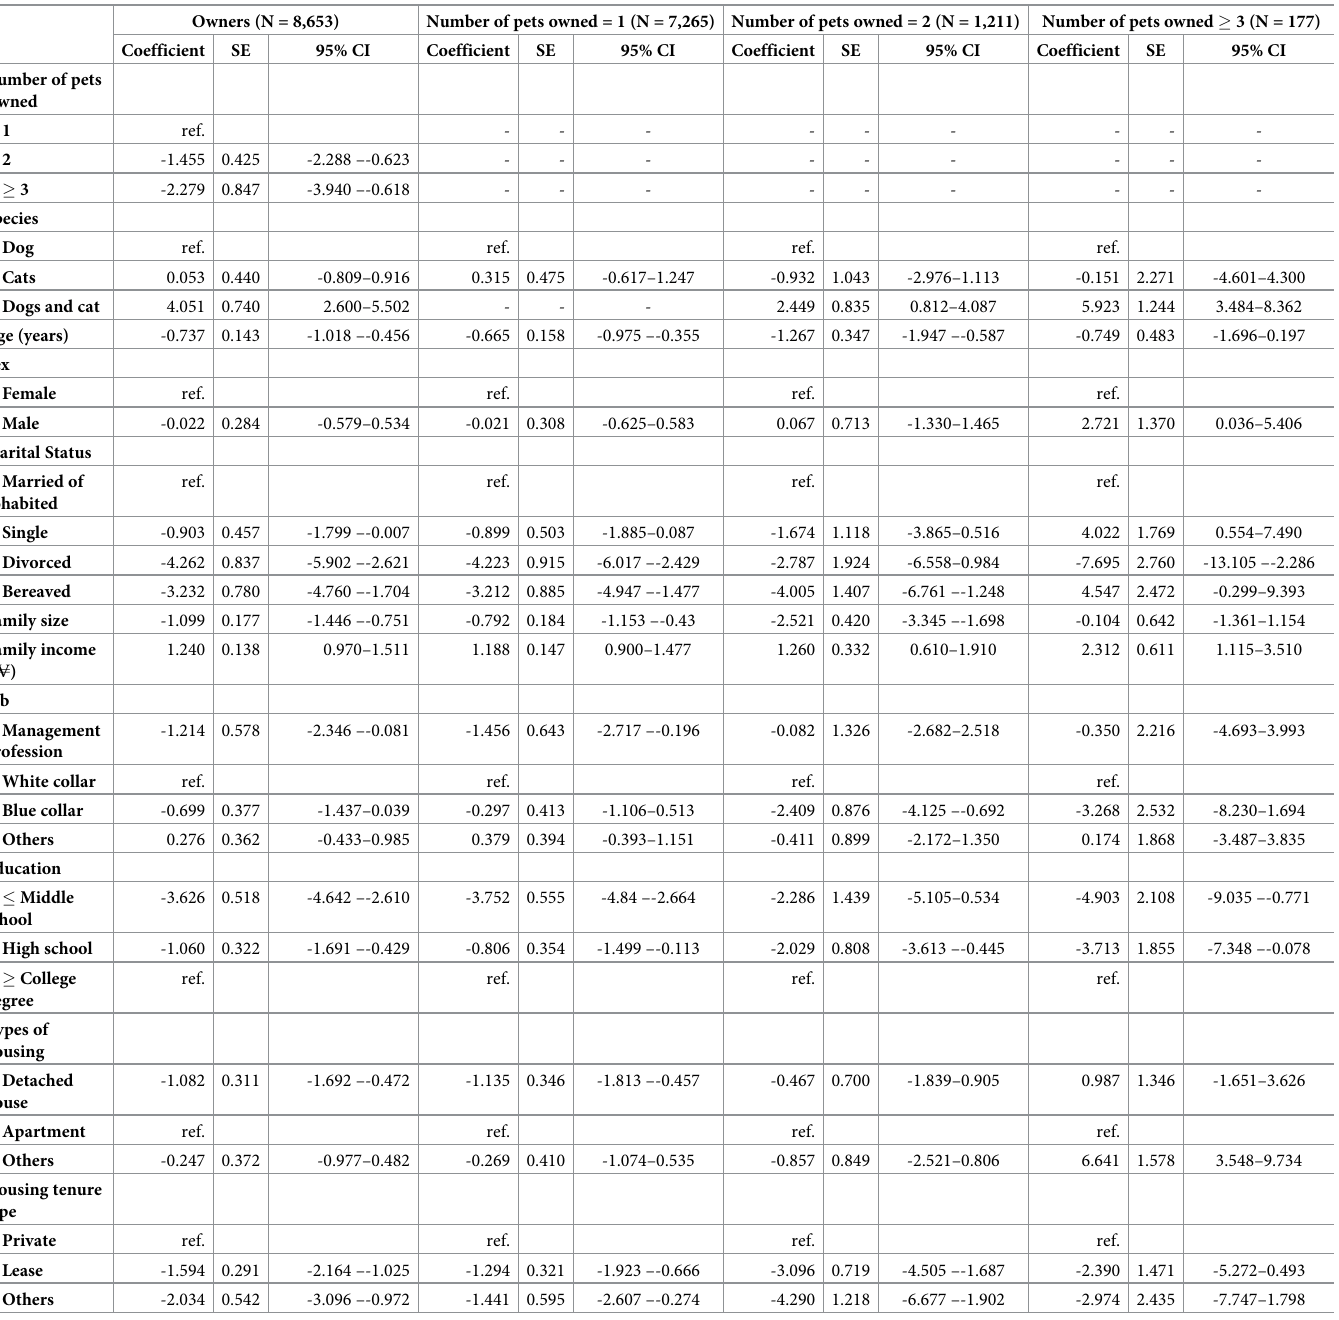
Table 4. Survey-weighted multiple linear regression on overall life satisfaction by number of pets owned. Owners (N =